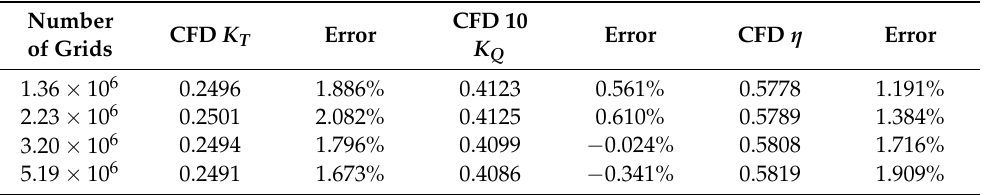
Table 3. Changes of hydrodynamic parameters using different grid sets.